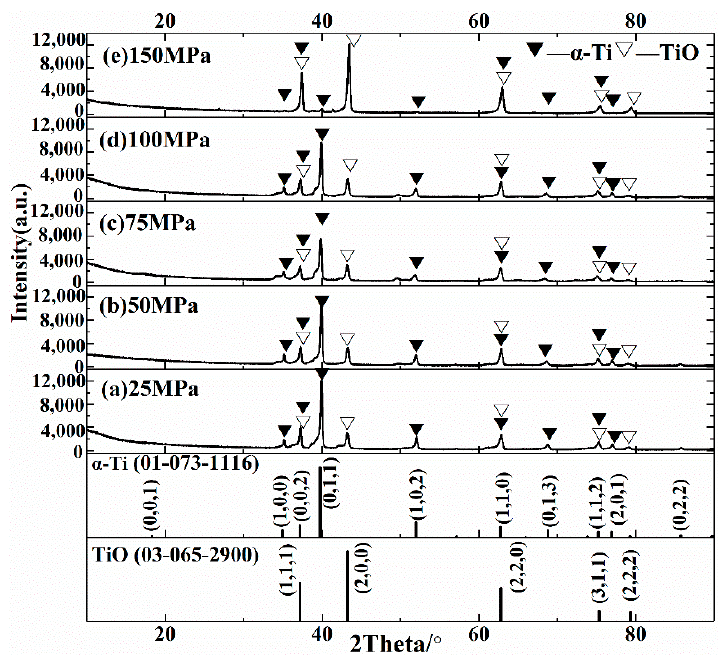
Figure 3. XRD patterns for SHS products (leached) of the Mg-TiO 2 system at different sample preparation pressures